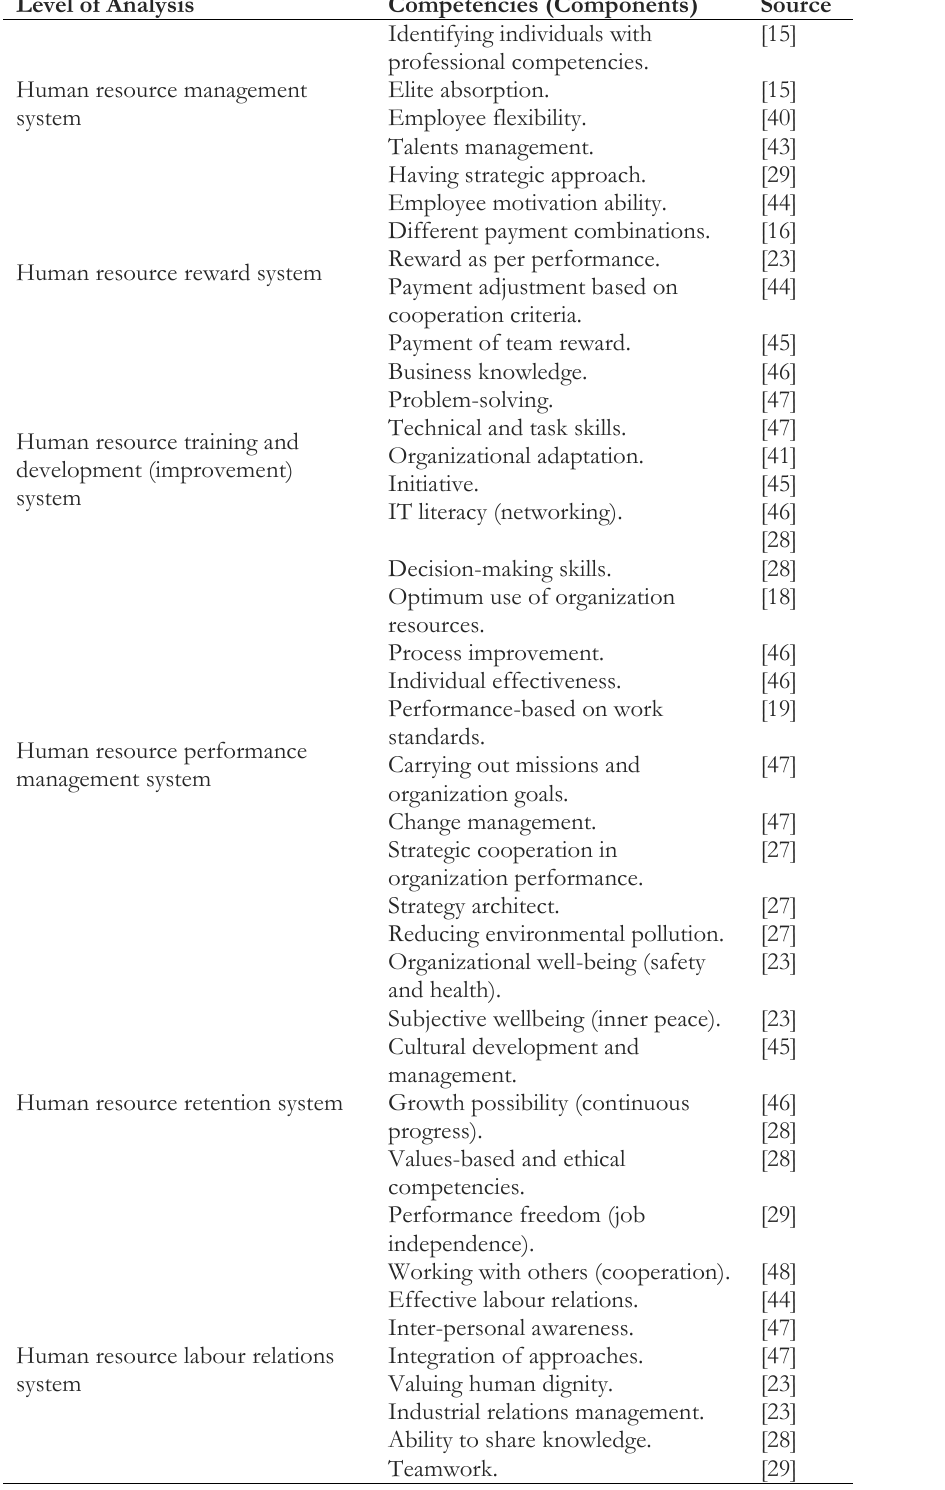
Table 1. Human resource management system competency components based on the theoretical literature of the